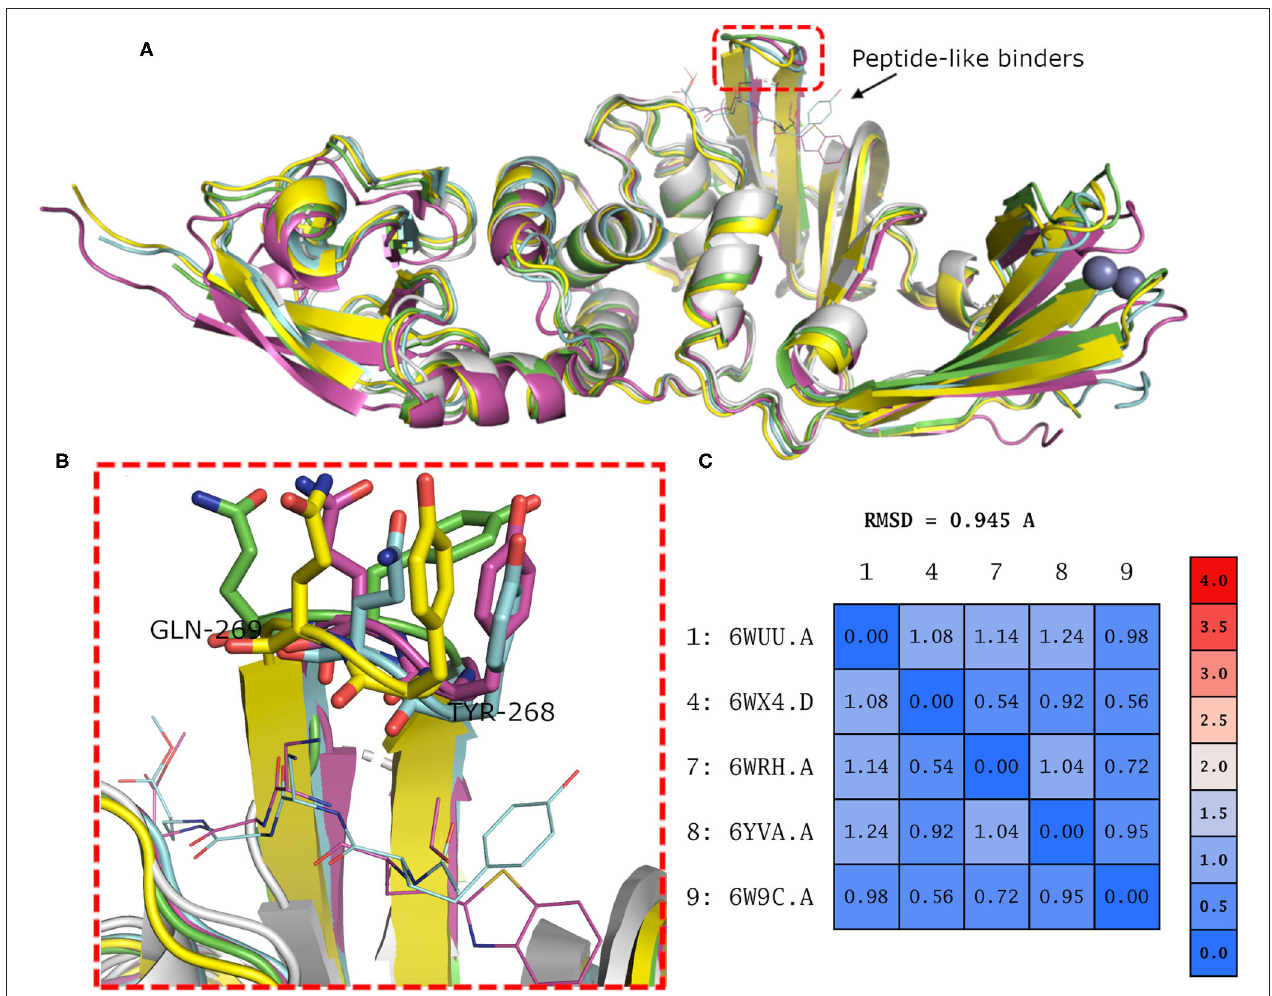
FIGURE 2 | (A) Superposition of the different SARS-CoV-2 PLpro structures including three apo structures and two complexed with peptide binders, namely, PDB ID: 6W9C, 6WRH, 6YVA, 6WUU, and 6WX4 as green, yellow, simon, purple, and gray cartoon representation, respectively. (B) Different conformations of the backbone and side chains of the key Tyr268 and Gln269 residues. (C) Pairwise RMSD matrix for all structures calculated for their α carbon atoms.